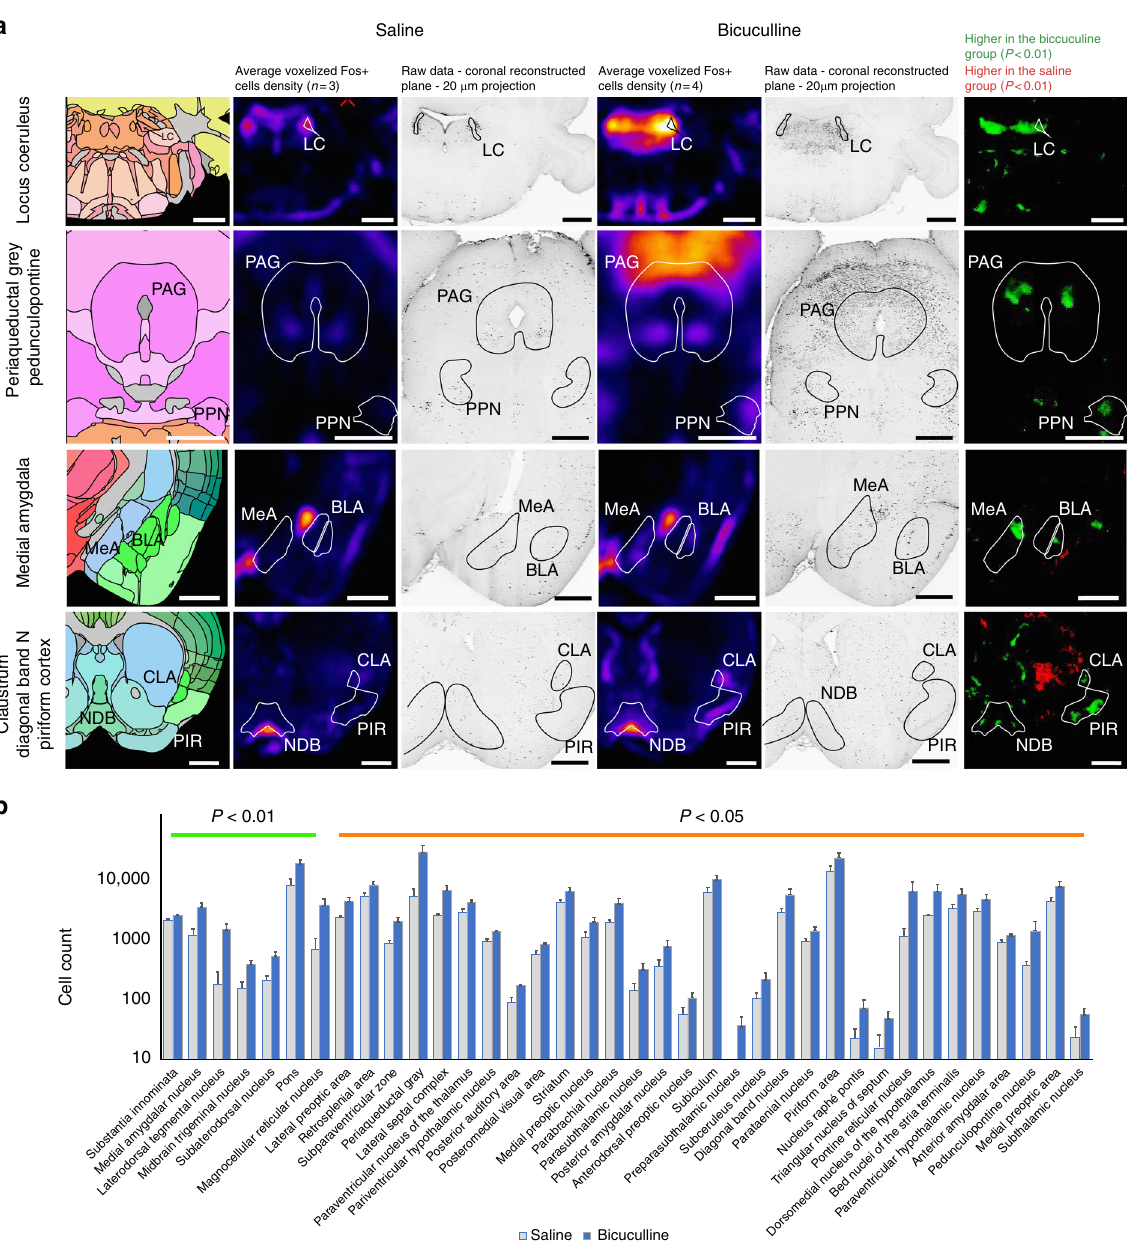
Fig. 3 aNGC recruits ventral and dorsal pathways to promote arousal. a Depicts coronal projections of reference annotation, averaged registered density maps, and p -value maps of areas with signi fi cantly higher c- Fos + cell densities after bicuculline microinjections ( n = 4; mice) in aNGC under constant anesthetic (Iso fl urane 1.25% vol). Same areas show c - Fos + cell densities in mice injected with saline ( n = 3; mice). b Shows automated segmentation of cell counts where c-Fos + cell densities were signi fi cantly higher than controls. The data represented as mean ± s.e.m. Reported p -values derived from two- tailed Mann – Whitney U test per brain area. - LC Locus coeruleus, PAG periaqueductal grey, PPN pedunculopontine tegmentum, MeA medial amygdala, BLA basolateral amygdala, PIR piriform cortex, NDB diagonal band nucleus, CLA claustrum. Scale bars are 500 µ m. Source data are provided as a Source Data fi